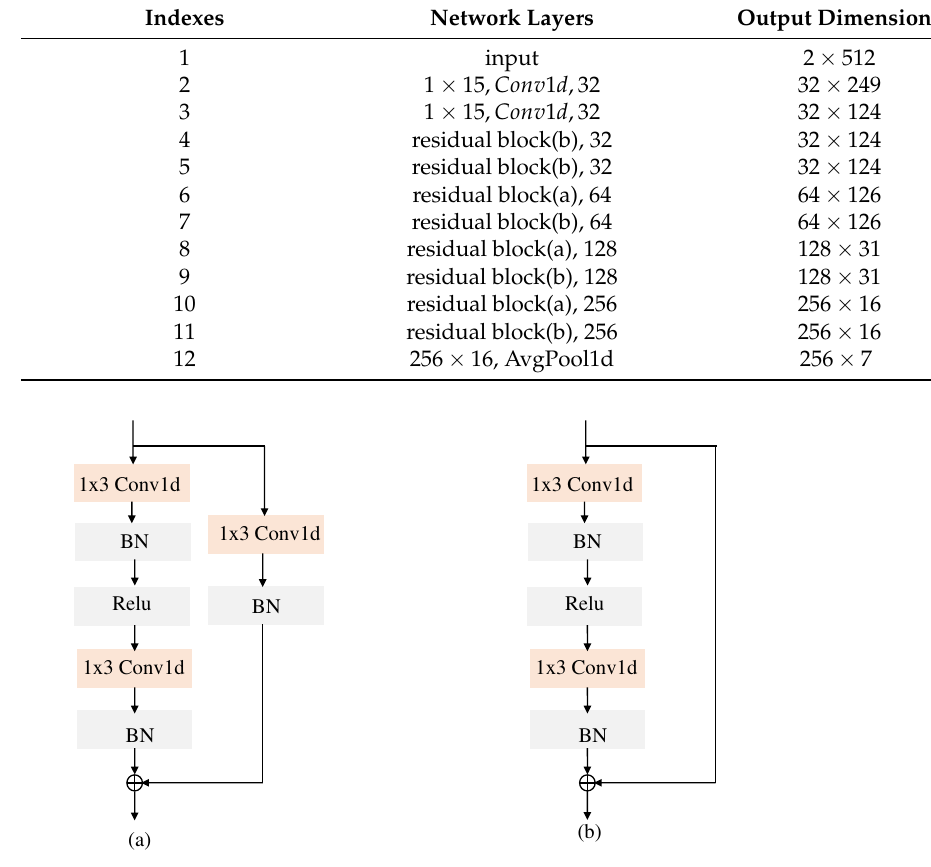
Figure 3. Two residual blocks. residual block ( a ) and residual block ( b ).